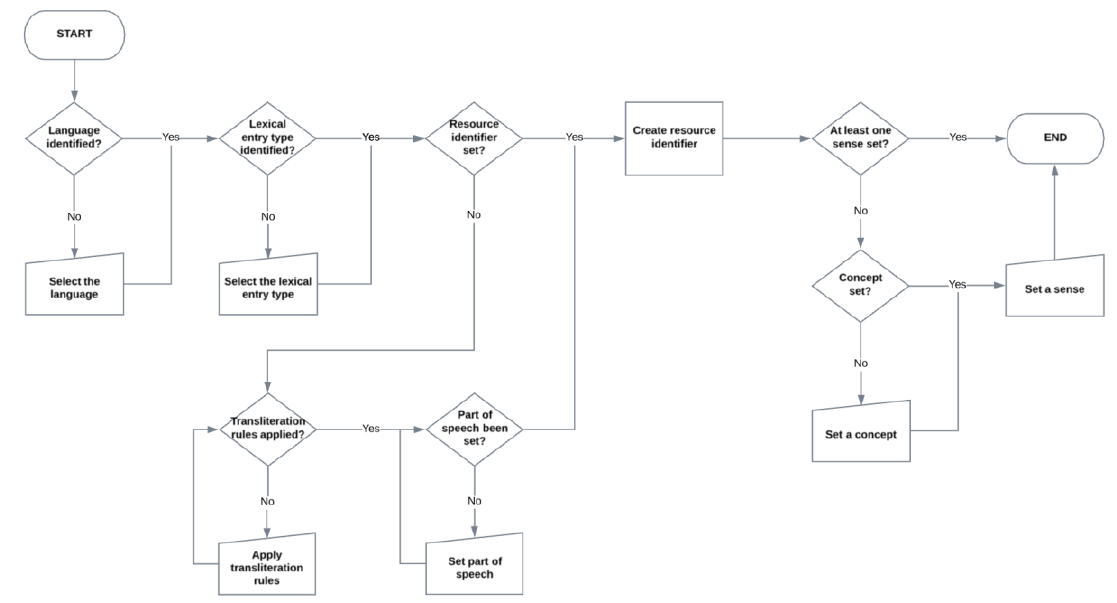
Figure 4. Illustration of the publication process of a single lexical entry.